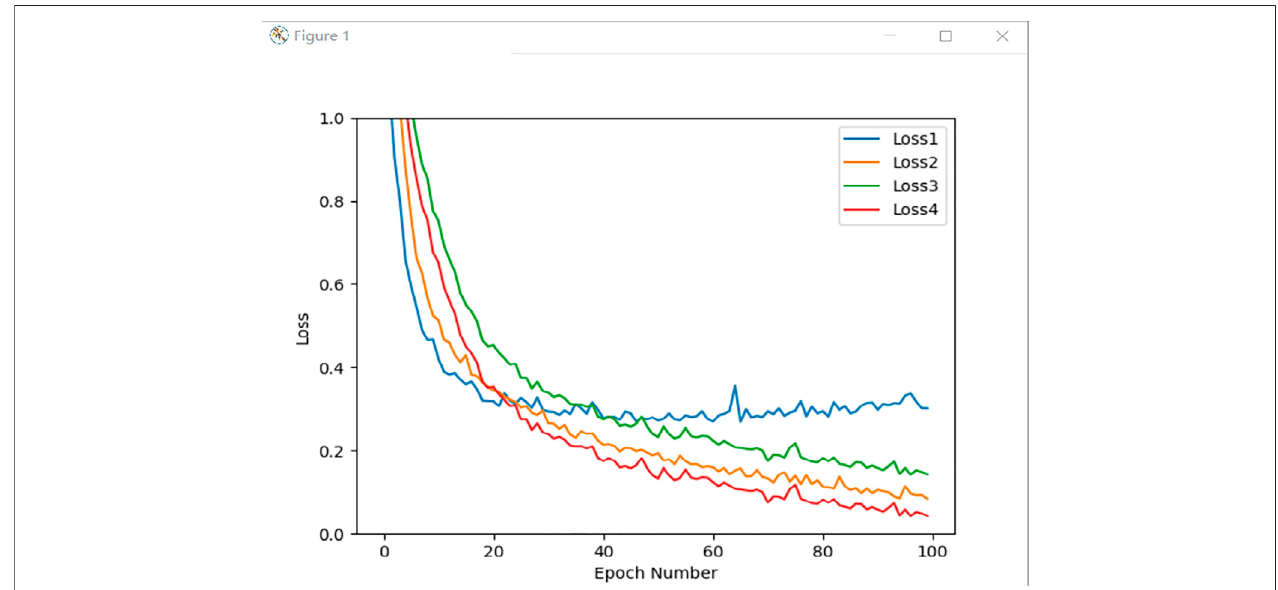
FIGURE 13 | Training loss value under different